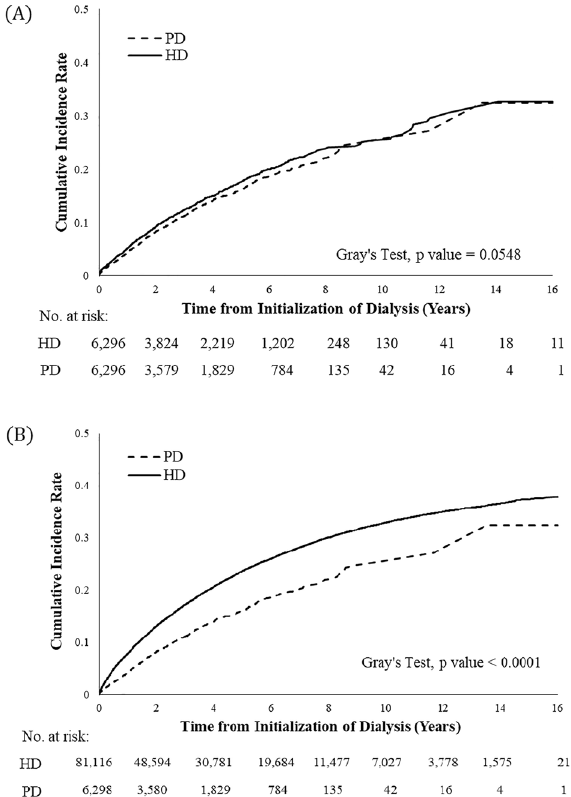
Figure 2. Cumulative incidence rates (CIRs) of gastrointestinal bleeding after accounting for the competing risk of mortality in matched ( A ) and unmatched ( B ) patients with hemodialysis (HD) and peritoneal dialysis (PD).